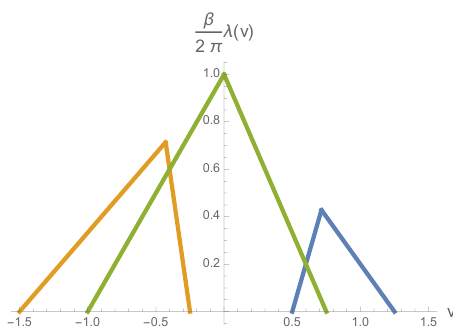
Figure 2 . The bound (2.8) for various values of v (cid:6)